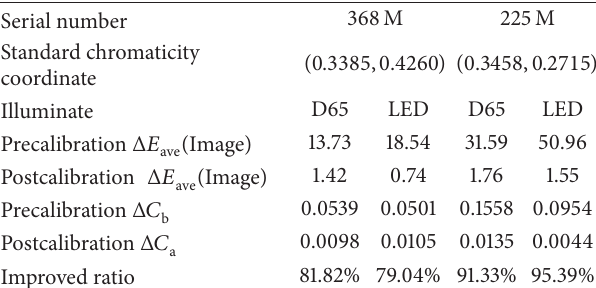
Table 4: The comparison of Δ𝐸 ave (Image), Δ C between captured images and theoretical images before and after